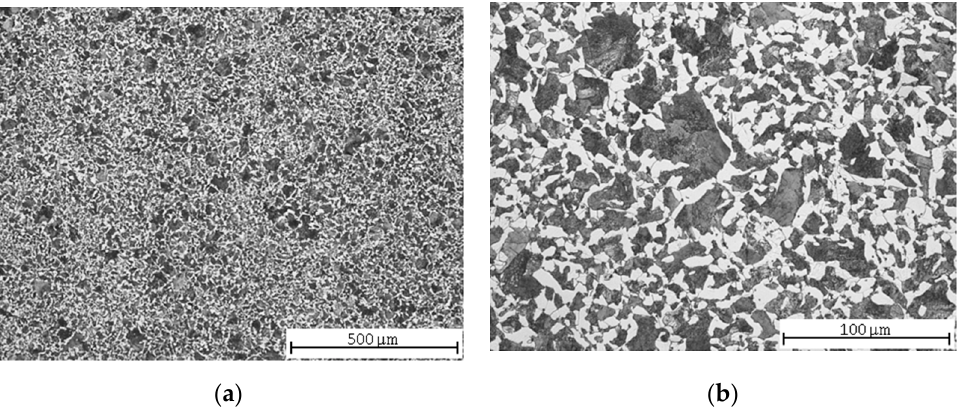
Figure 5. 37MnSi5 steel microstructures after normalization annealing: ( a ) central part; ( b ) detail.